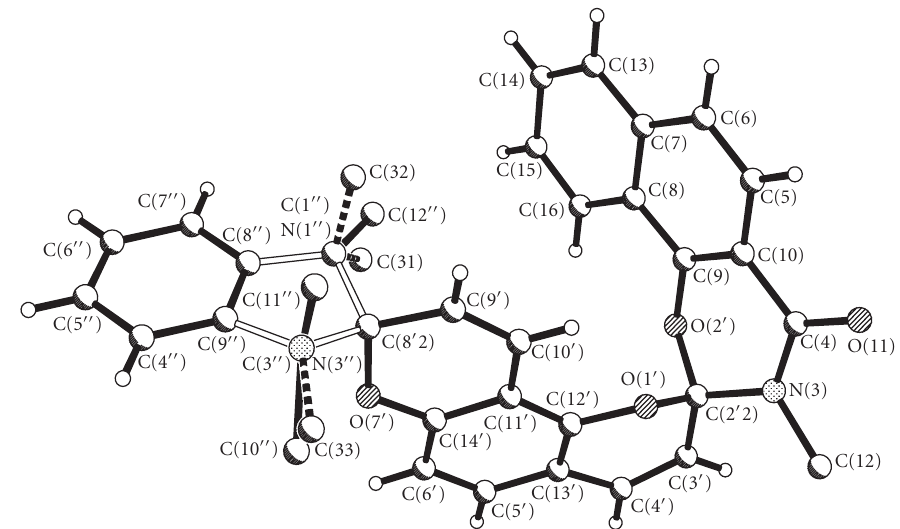
Figure 4: Data of the X-ray analysis of compound VIII